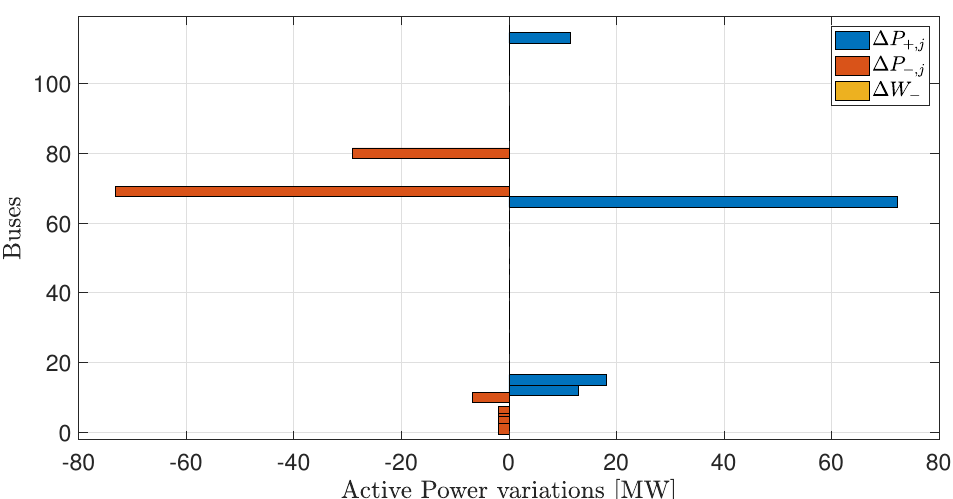
Figure 4. Set-point variations of DGUs and RESU curtailment after the active power control − Scenario APC1.